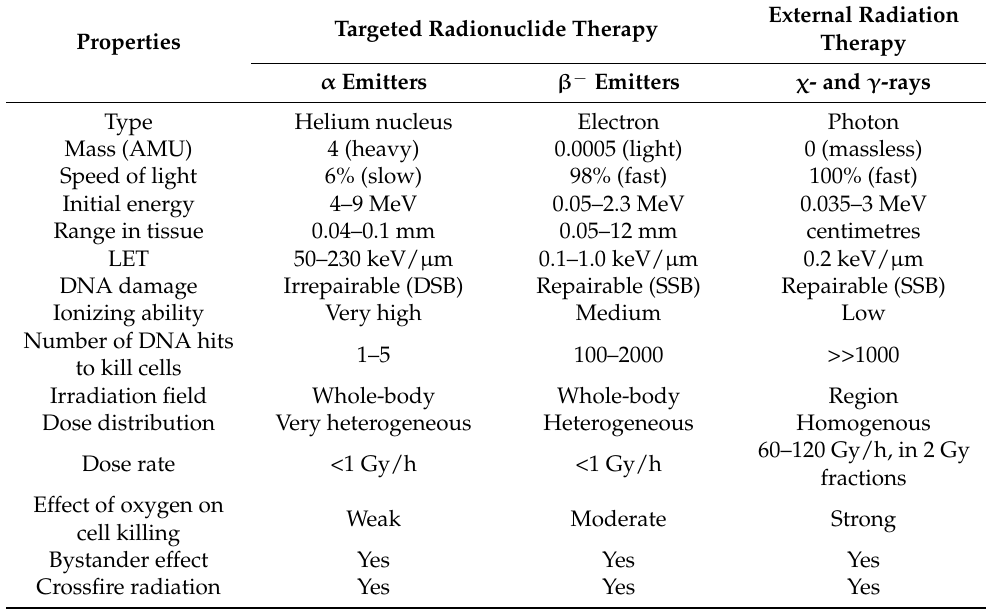
Table 1. Comparison of conventional external radiation radiotherapy and targeted radionuclide therapy [60–62]. AMU, atomic mass units LET, linear energy transfer; DBS, double-strand breaks; SSB, single-strand